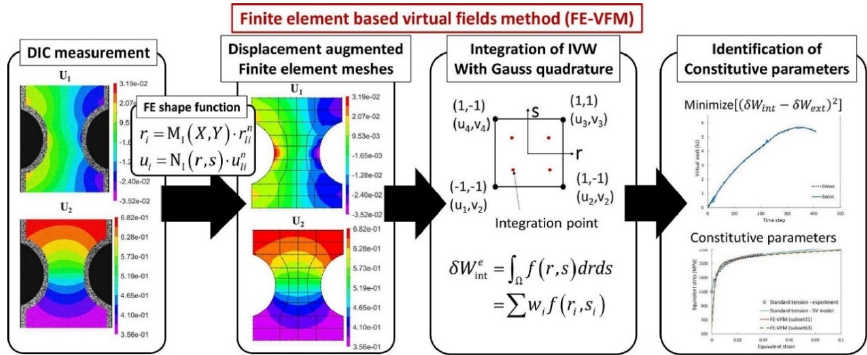
Figure 22. Finite element-based virtual fields method with pseudo-real deformation fields for identifying constitutive parameters. Reprinted from Ref. [314] with permission. Copyright 2021, Elsevier.